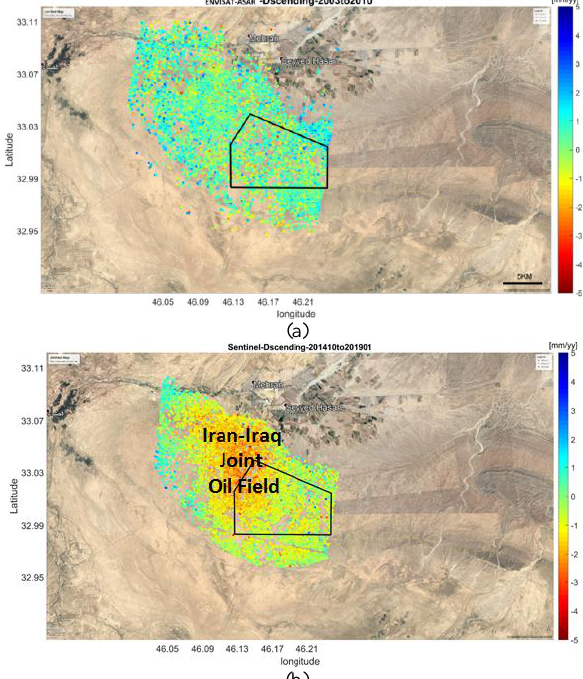
(b) Figure 7. Deformation velocity map (a) ENVISAT-ASAR between 2003 to 2009 with reference point (46.22, 33.02) (b)